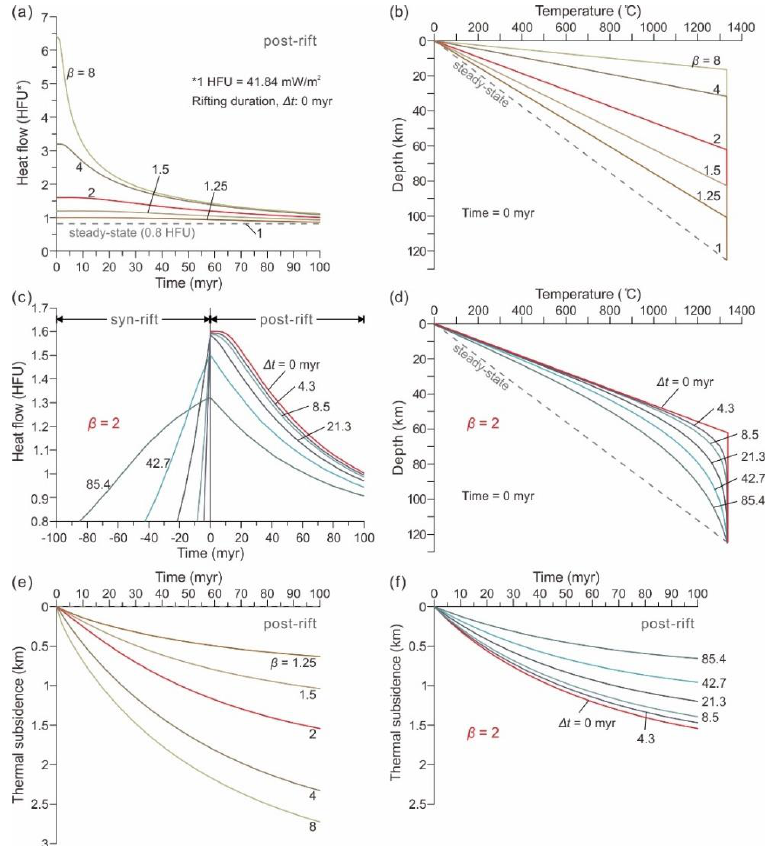
Figure 3. Numerical model settings in this study; ( a ) surface heat flow and ( b ) geothermal gradient models, applying 𝛽 = 1, 1.25, 1.5, 2, 4, and 8. ( c ) Surface heat flow and ( d ) geothermal gradient models of 𝛽 = 2, applying ∆𝑡 = 0, 4.3, 8.5, 21.3, 42.7, and 85.4. ( e , f ) Post-rift thermal subsidence models, applying the above values of 𝛽 and ∆𝑡 . Analytic and numerical solutions are from [40–42]. Negative and positive values on the time axis indicate the syn-rift and post-rift phases, respectively. Geothermal gradient models depict rifting cessation at time 0 myr; 1 Heat Flow Unit (HFU) corresponds to 41.84 mW/m 2 . The models where 𝛽 = 1 (dashed lines) represents the steady-state with 0.8 HFU.